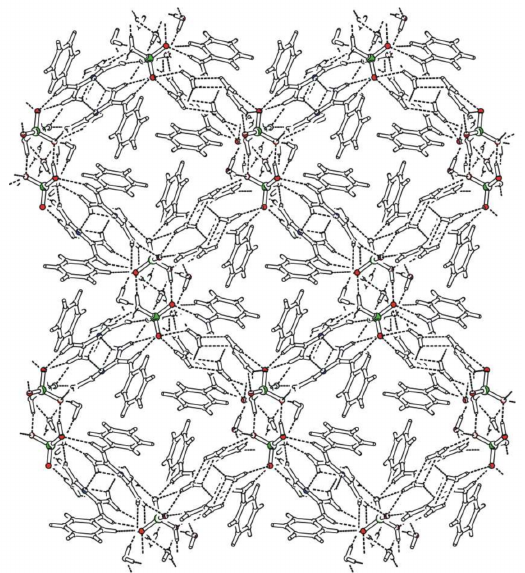
Figure 5. Packing scheme of phbigua 2 HPO 4 1.5H 2 O (view along the a axis direction); dashed lines indicate hydrogen bonds.